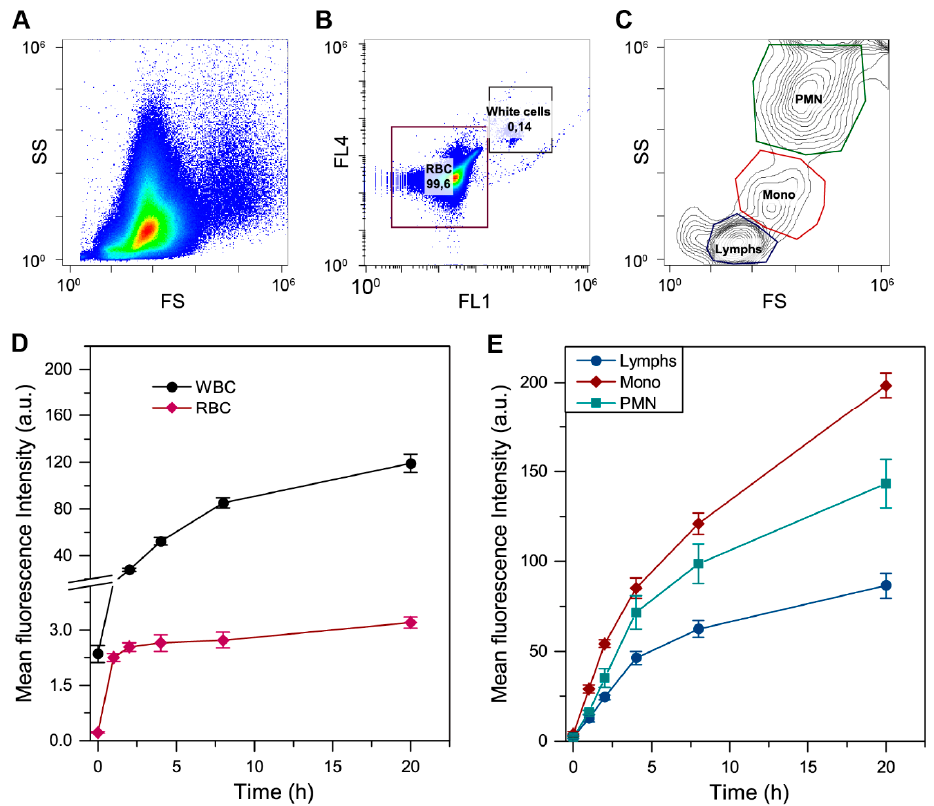
Figure 2. Flow cytometry analysis of mTHPC distribution in blood components. ( A ) Side scatter (SS)/forward scatter (FS) dot plot of blood cells population. ( B ) Separation of RBC and WBC populations using CD-45 antibody (FL1). ( C ) Separation of white blood cells on Lymph (blue), Mono (red) and PMN (green) subpopulations based on SS/FS characteristics. ( D ) Uptake kinetics of mTHPC in RBC ( ♦ ) and WBC ( ● ) cells. ( E ) Uptake kinetics of mTHPC in Lymps ( ● ), Mono ( ♦ ), and PMN ( ■ ) cells. Graphs represent the mean ± SD. The concentration of mTHPC was 4.5 µM.